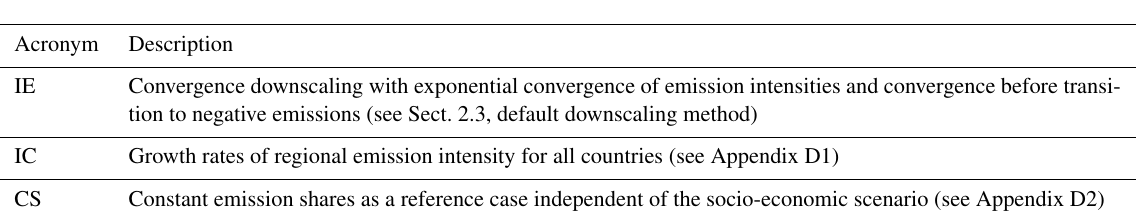
Table A4. Downscaling